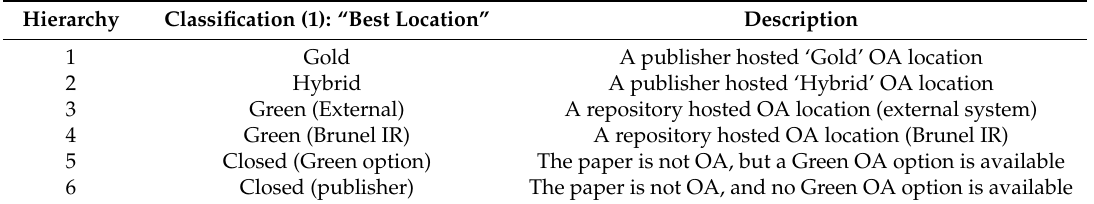
Table 1. The open access classification (1) by ‘best’ available location.